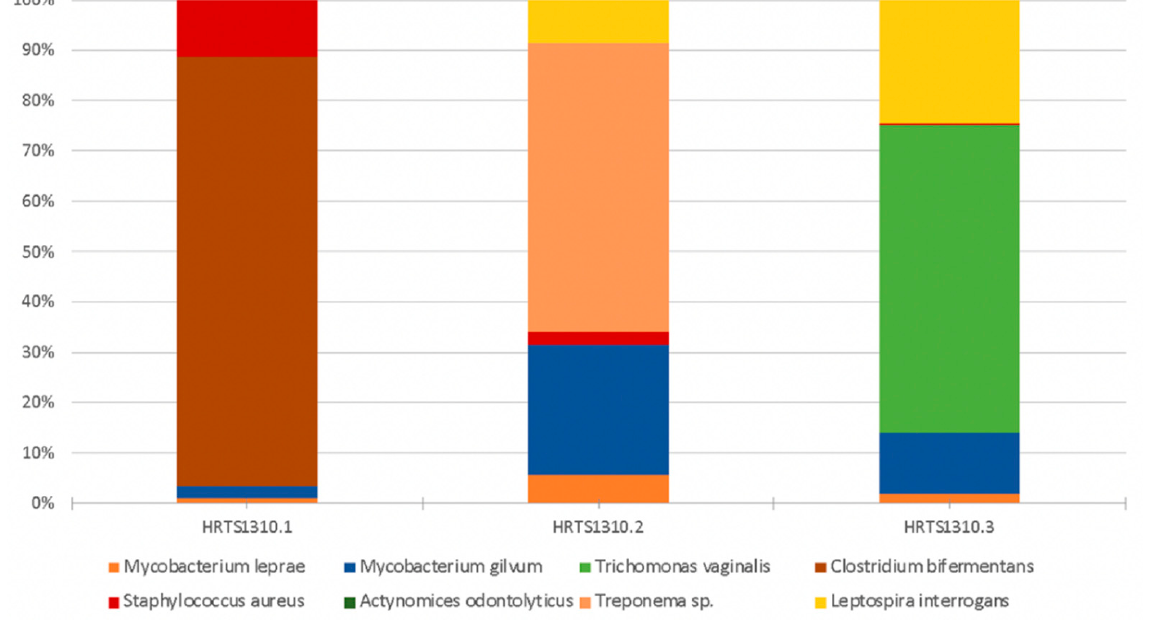
Figure 2. Percentual distribution of the most abundant pathogenic microorganisms (100% = all pathogen readings per sample). The color breakdown represents the pathogens found per sample.